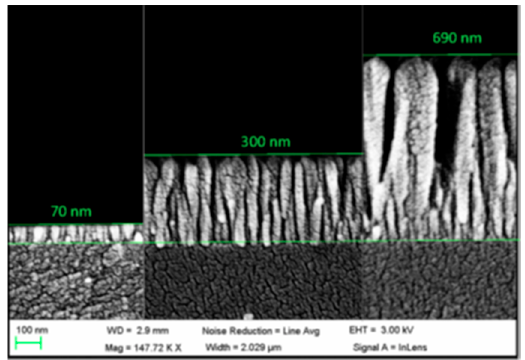
Figure 25. SEM images from In 2 O 3 films with different deposition times: 30 s (70 nm), 150 s (300 nm) and 5 min (690 s). The resulting coating is homogeneous and it is formed by compact nanorods. Reprinted [116] from with permission from